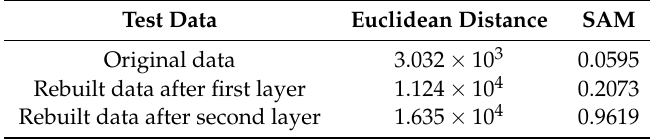
Table 3. Euclidean distance and SAM between sub-pixel anomaly and average background spectra.